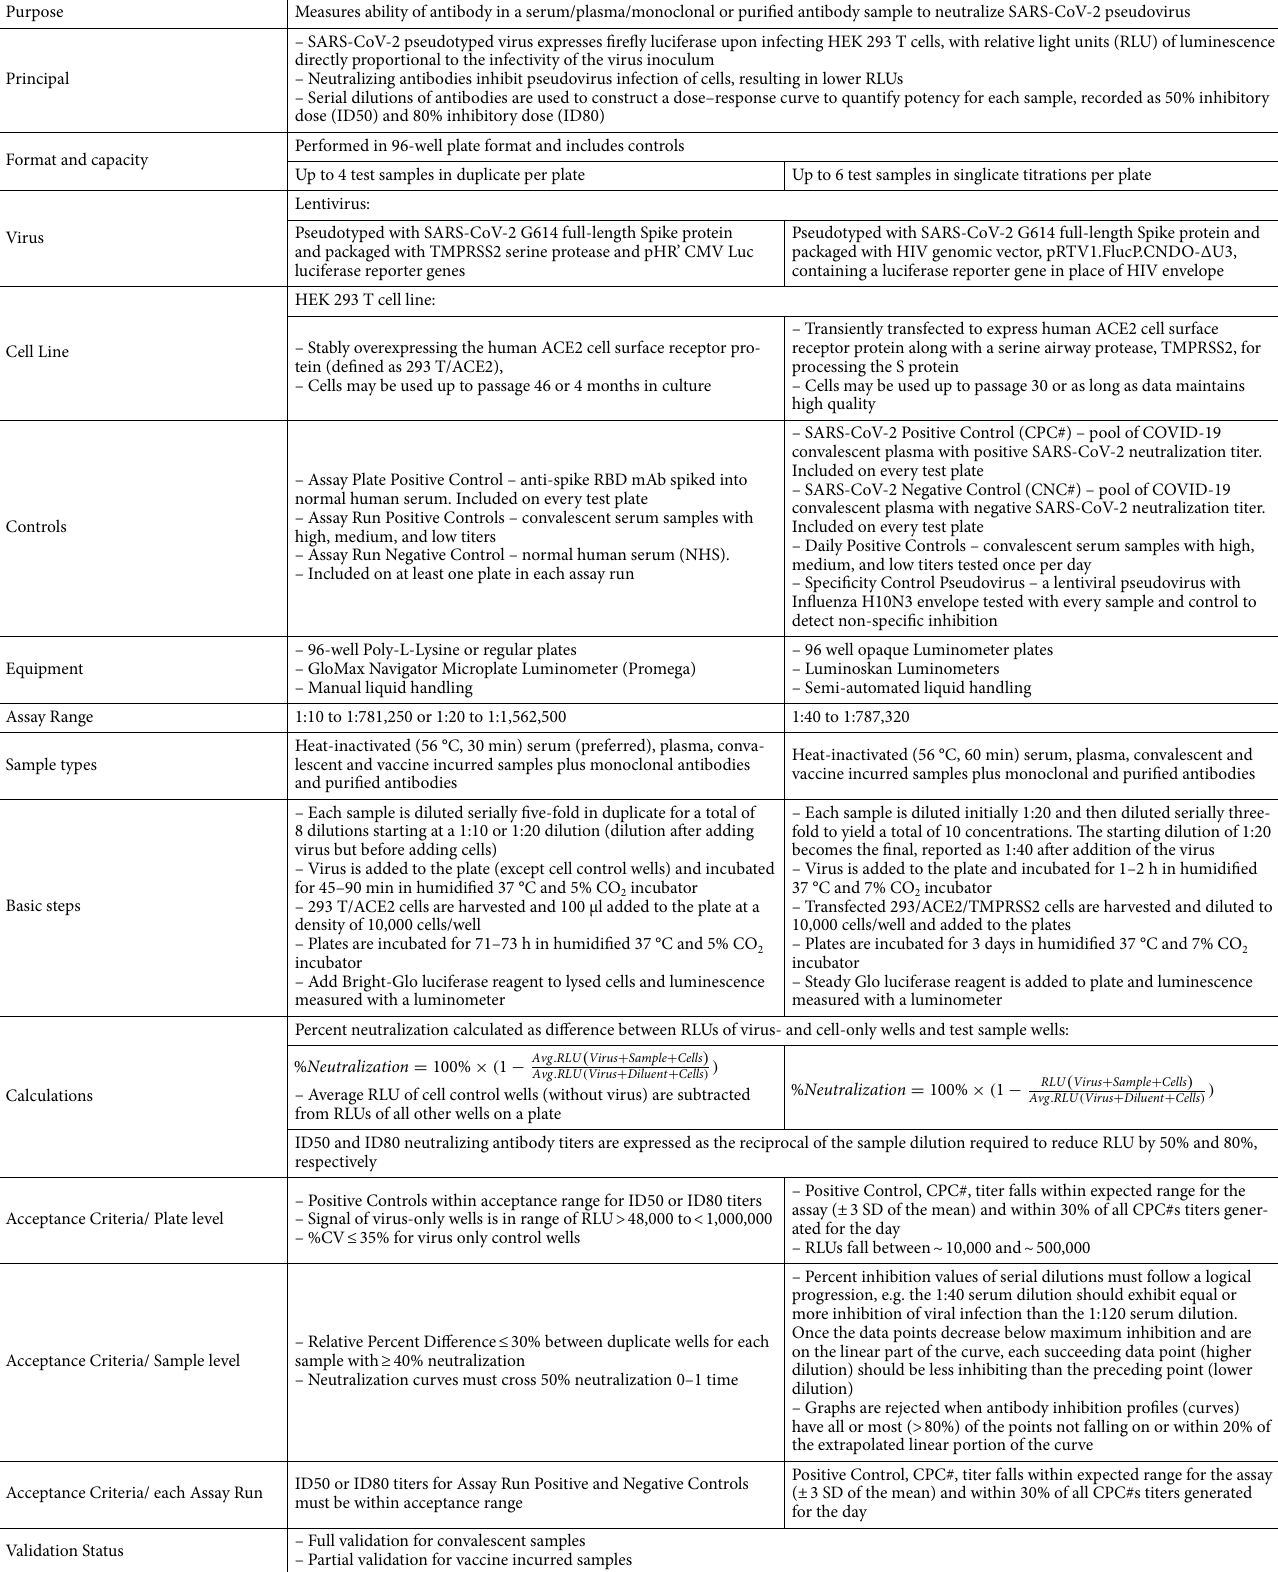
Table 1. Overview comparison of the Duke versus Monogram